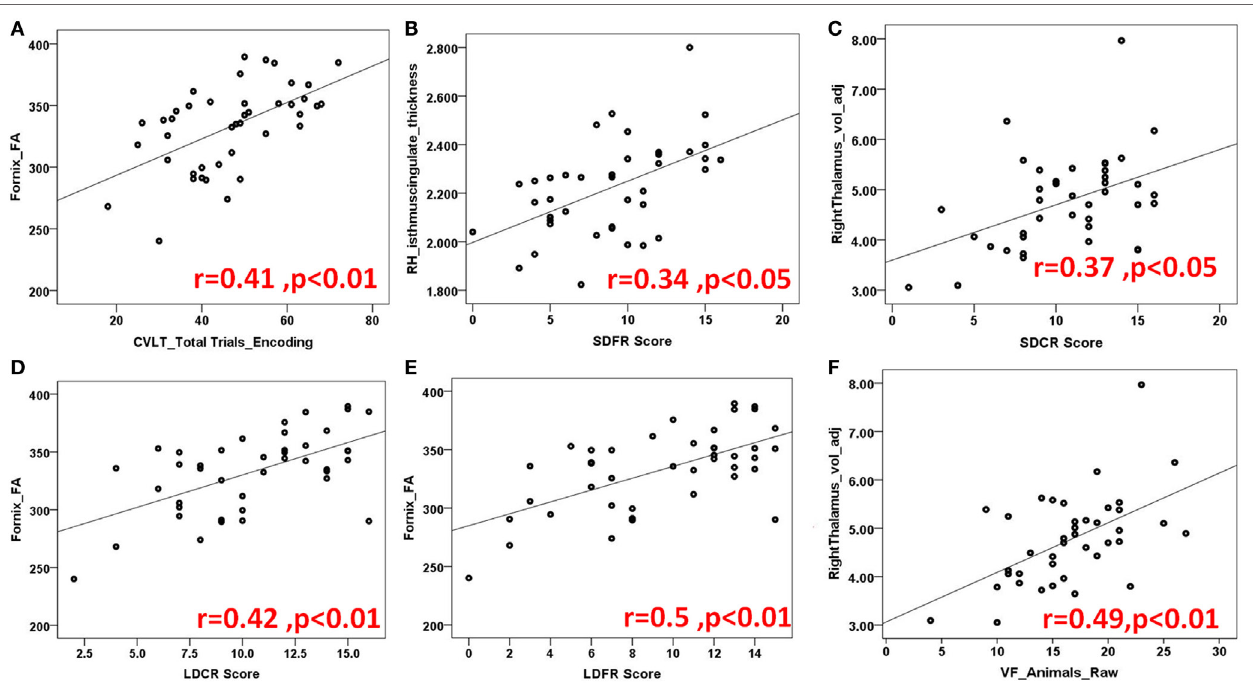
FigUre 3 | Demonstration of several scatter plots of limbic structures and California verbal learning (CVLT) (a–e) and controlled word association test [semantic verbal fluency (VF)] (F) . Abbreviations: FA, fractional anisotropy; RH, right hemisphere; SDFR, Short-Delayed Free Recall; SDCR, short-delayed cue recall; LDCR, Long-delayed cue recall; LDFR, Long Delayed Free Recall; voladj, volume adjusted for intracranial